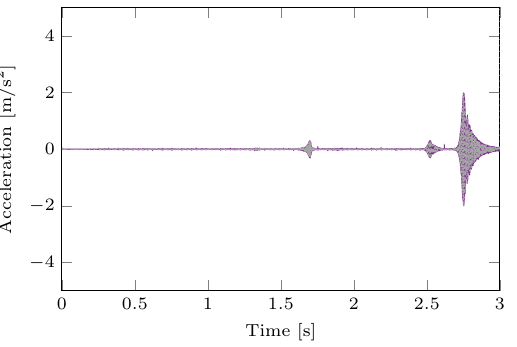
Figure 7. Vertical acceleration of point T : comparison between Subs-b and FiLm method.